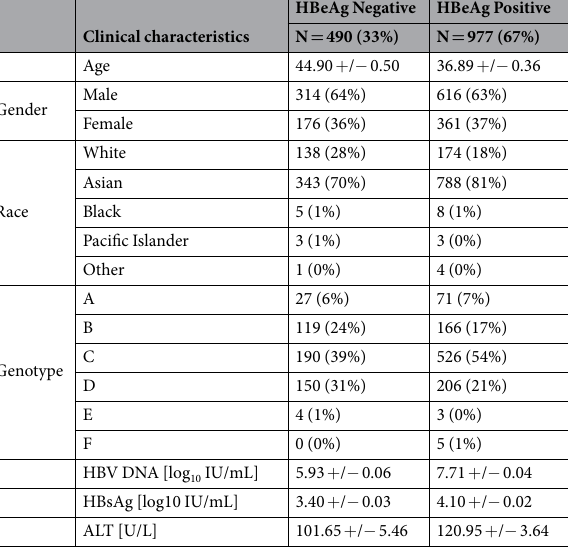
Table 1. Clinical characteristics of patients included in this